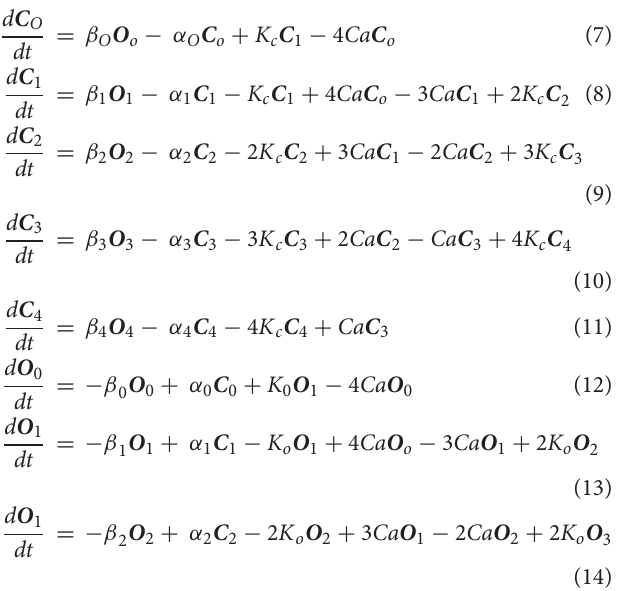
FIGURE 3 | Delayed rectifier K + currents, I K DR , in a human chondrocyte. (A) Examples of I K − to membrane potentials of 40, 30, 20, 10, 0, 20, and 50mV. Records have been corrected for capacity and linear leak currents. (B) Plot of I K − − − − + + conductance (per pF) vs. membrane voltage, V. Conductance was obtained by dividing peak I K 16 cells (mean SEM). The best-fit Boltzmann relationship (red line) is the factor α K-DR (Equation ±